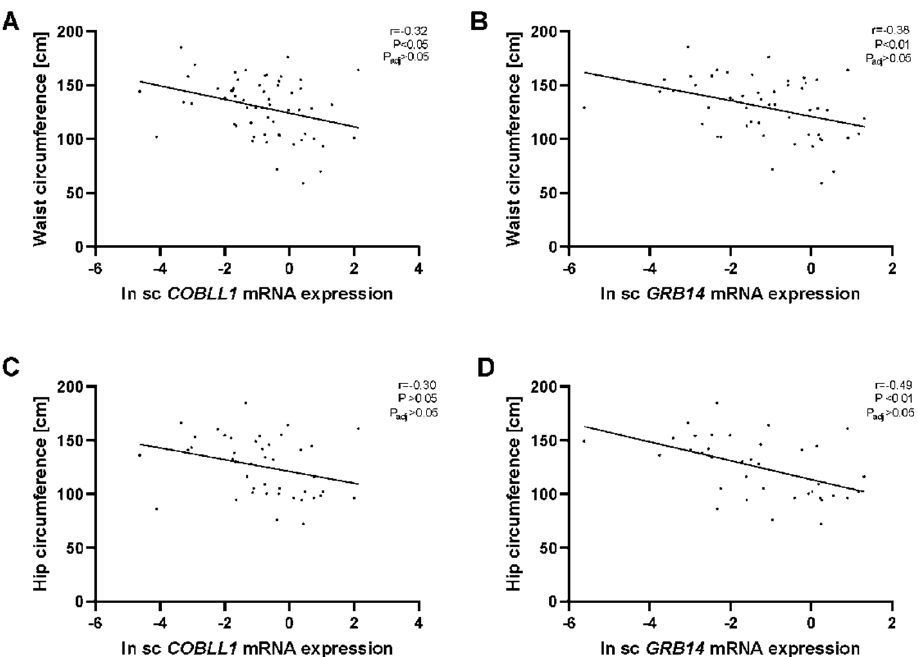
Figure 2. Correlation between AT COBLL1/GRB14 mRNA expression and fat distribution variables. The correlation of natural log transformed sc COBLL1/GRB14 mRNA levels with waist circumference ( A , B , n = 59/53) and hip circumference ( C , D , n = 43/37) is shown. Pearson correlation coefficients and corresponding p -value have been included; p adj : adjusted by BMI, age, and sex; sc: subcutaneous adipose tissue.